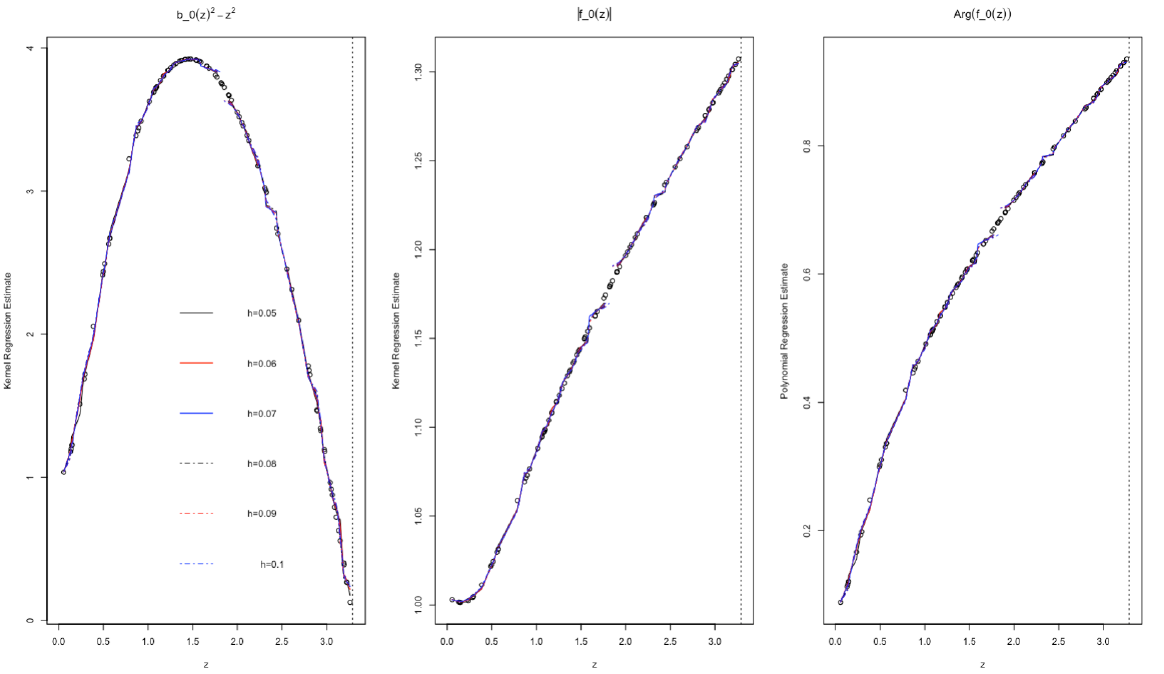
Figure 8. The estimates of critical collapse functions corresponding to a β solution of a hyperbolic case based on a kernel regression method with bandwidth parameters h = { 0.05,0.06,0.07,0.08,0.09,0.10 } based on a training sample of size n =